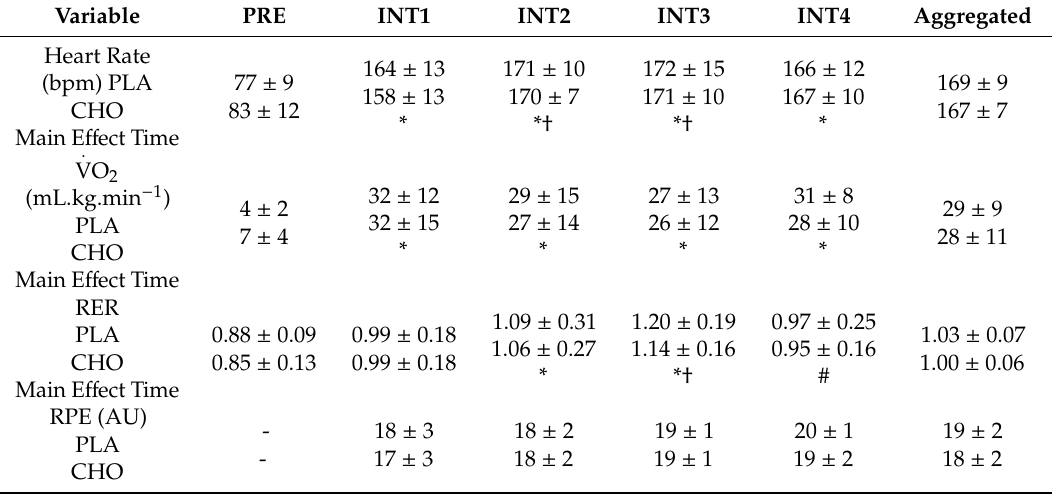
Table 1. Physiological and Performance variables between intervals and aggregated across intervals (mean of intervals